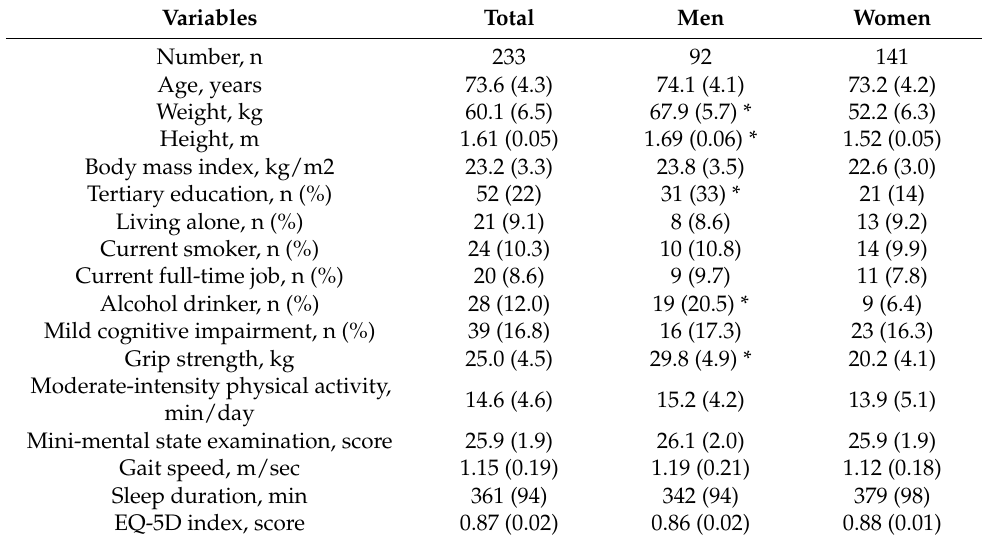
Table 1. Selected anthropometric, social, physical and mental characteristics of